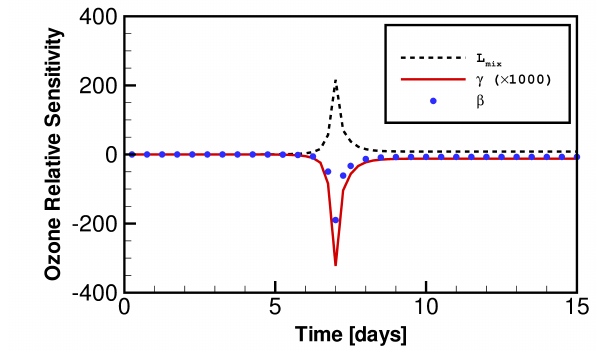
Fig. 7. Temporal evolutions of the sensitivity coefficients of the ozone concentration for L mix , γ , and β .